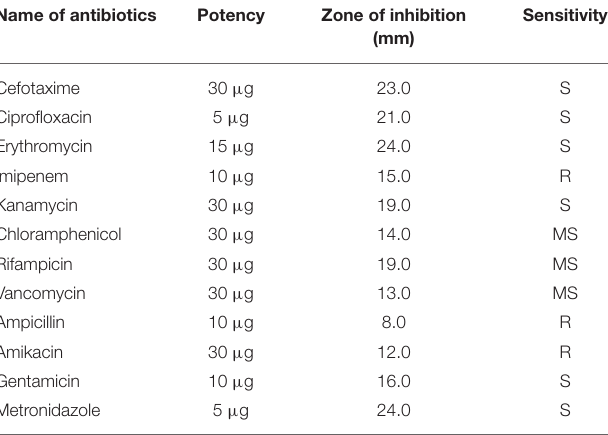
TABLE 3 | Antibiotic susceptibility profile of S. boulardii isolate.